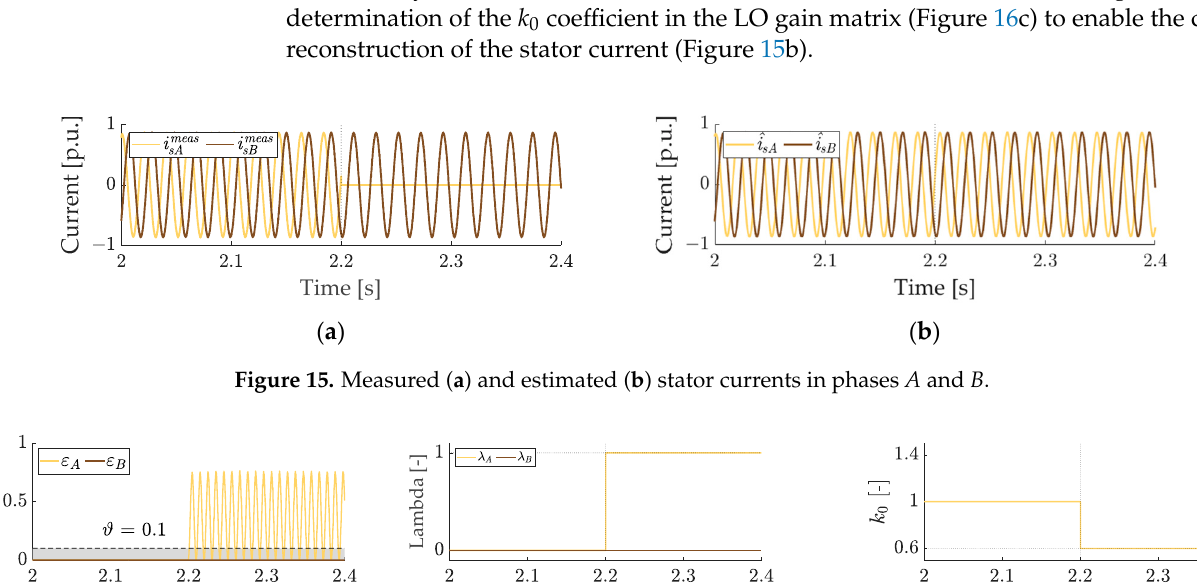
Figure 14. Waveforms of the rotor flux amplitude ( a ) and angular speed ( b ).